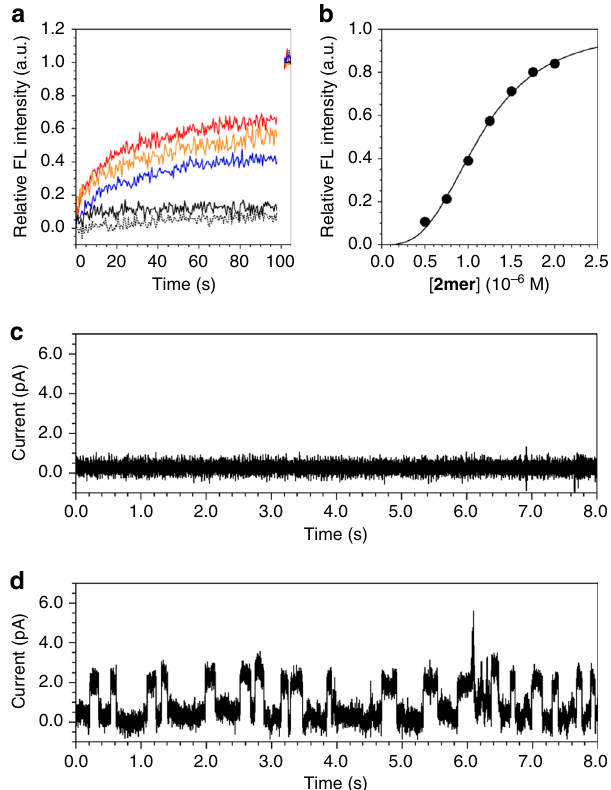
Fig. 4 Ligand-gated ion transportation of membrane-embedded multiblock amphiphile. a Changes in the 510-nm fl uorescence intensity of HPTS encapsulated in DOPC (cid:129) 2mer post LUVs in HEPES buffer containing PA at 20 °C as a function of time after the addition of (red) LiOH, (orange) NaOH and (blue) KOH at 0 sec followed by addition of 1.0 wt% Triton X- 100 at 100 sec ([DOPC] = 400 μ M, [ 2mer ] = 0.75 μ M, [PA] = 10 mM, [HPTS] = 30 μ M, 20 mM HEPES, 50 mM KCl, pH 7.1, excitation at λ = 460 nm, emission at λ = 510 nm). The black broken and solid lines show changes in the fl uorescence intensities of HPTS encapsulated in (broken) DOPC (cid:129) 2mer post LUVs and (solid) DOPC (cid:129) 2mer post LUVs containing PA in the intravesicular medium in HEPES buffer in the absence of PA in the extravesicular medium upon addition of LiOH. Δ pH = 0.8 (7.1 – 7.9). b Plots of relative 510-nm fl uorescence intensities of HPTS encapsulated in DOPC (cid:129) 2mer post LUVs at 20 s after the addition of KOH in 20 mM HEPES 2mer ([DOPC] = 400 μ M, [PA] = 10 mM, [HPTS] = 30 μ M). Curve- fi